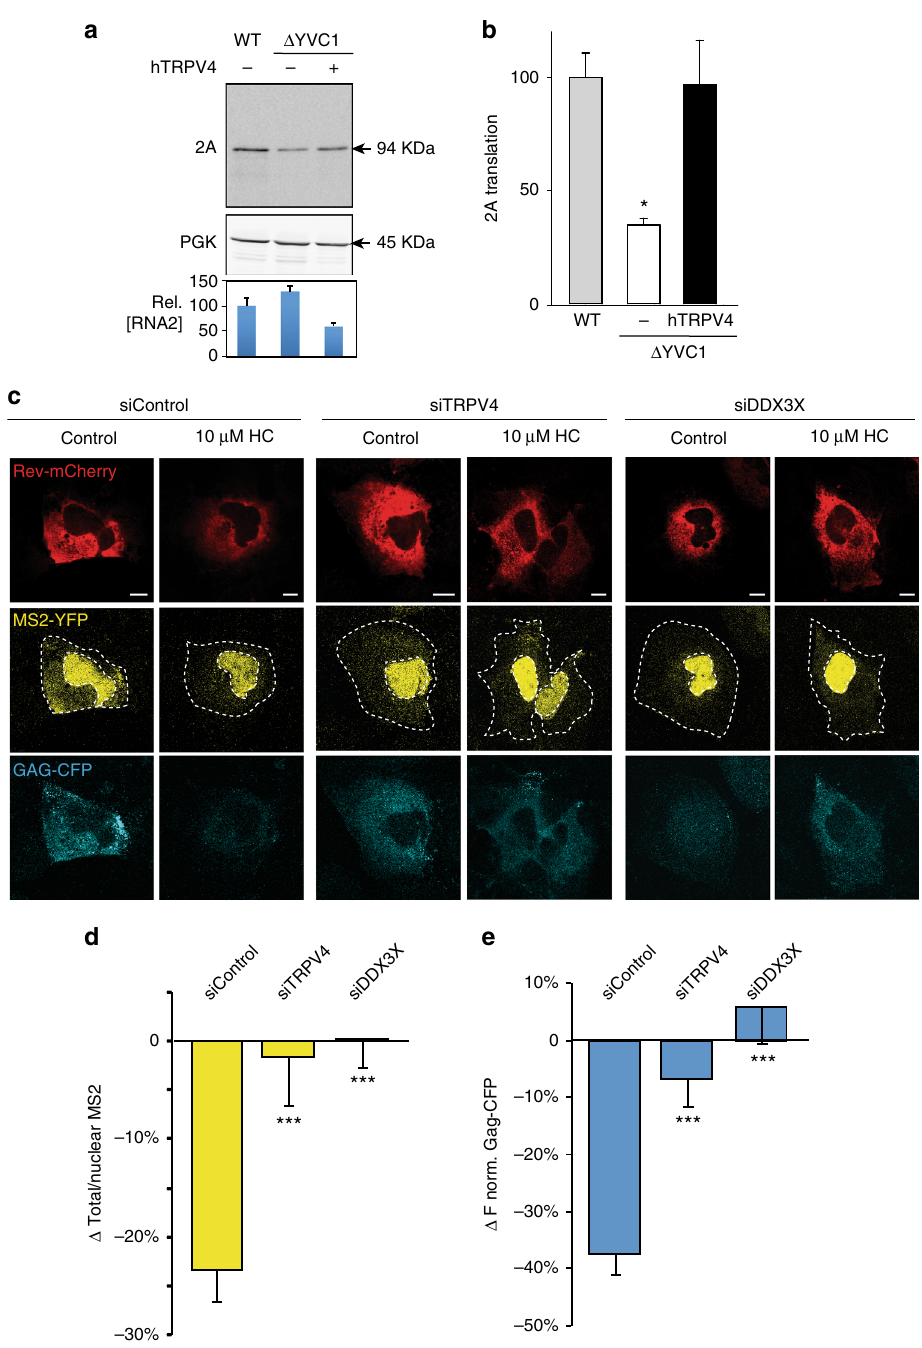
Fig. 5 TRPV4 promotes nuclear export and translation of viral RNA. a Translation of viral RNA2 in yeast. Western blot analysis of protein 2A (top), protein PGK (middle) and qPCR quanti fi cation of viral RNA2 normalized to actin (lower) obtained in WT, Δ Yvc1 and Δ Yvc1 yeast transformed with hTRPV4. Differences in mean RNA2 values were not statistically signi fi cant ( P > 0.05, n = 3) as determined by one-way ANOVA followed by a Bonferroni post hoc test when compared WT yeast with Δ Yvc1 or Δ Yvc1 + hTRPV4 ( P = 0.26 and P = 0.08, respectively). b Quanti fi cation of RNA2 translation, calculated as the ratio of corrected protein 2a/RNA2. c Representative images of HeLa cells transfected with Rev-mCherry, RRE-gRNA and MS2-YFP, and stained with DAPI. d Quanti fi cation of nuclear export of gRNA, calculated as the difference in the total/nuclear MS2-YFP ratio between HC067047 and control conditions in cells transfected with siControl, siTRPV4 and siDDX3X. Mean ( ± SEM) of 67 siControl cells, 46 siTRPV4 cells and 47 siDDX3X analyzed from two independent experiments. e Quanti fi cation of Gag-CFP signal expressed as a negative difference in the GAG-CFP intensity between HC067047 and control conditions in cells transfected with siControl, siTRPV4 and siDDX3X. Cell contour marked by a dotted line. Mean ± SEM of 67 siControl cells, 46 siTRPV4 cells and 47 siDDX3X analyzed from two independent experiments. The data are means± SEM. * P < 0.05 and *** P < 0.001 when comparing WT with any other condition ( b ) or siControl versus any other condition ( d , e ) as determined by one-way ANOVA followed by a Bonferroni post hoc test. Bartlett ’ s test for equal variances reported signi fi cant differences in d and e ( P = 0.01 and P = 0.0001, respectively). Scale bar = 10 μ